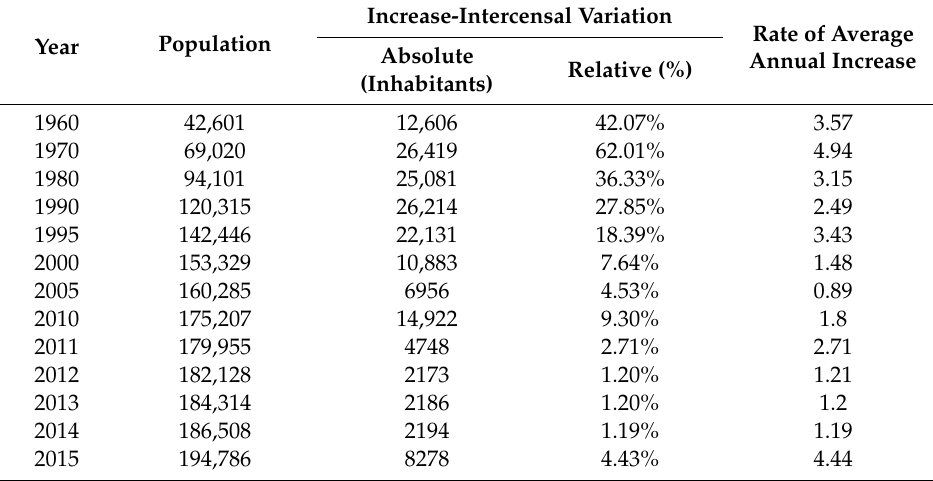
Table 3. Population growth in the Cuautla area, 1950–2015.